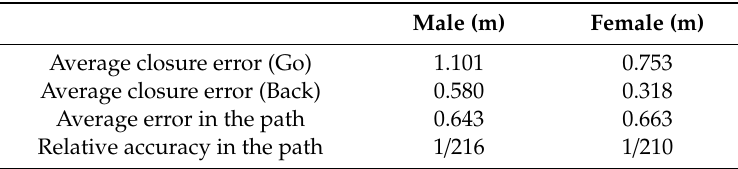
Table 5. Results of 15 participants for each male and female.